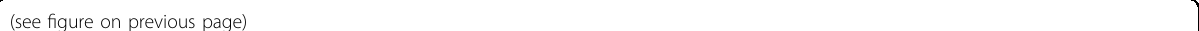
Fig. 5 CoV-2-EVs mediate the entry of SARS-CoV-2 into cells independent of known receptors and cofactors on host cells. a Expression levels of hACE-2, NRP-1, AXL and TMPRSS2 in different cell lines. b Supernatant viral copies of Vero E6, A549 and SCC7 cells after infection with SARS- CoV-2 for 24 and 48 h, respectively. Results are from more than 3 independent experiments. c Vero E6, A549 and SCC7 cells were incubated with isolated CoV-2-EVs, and supernatant viral copies were quanti fi ed by qRT-PCR. Results are from more than 6 independent experiments. d Images of Vero E6, A549 and SCC7 cells that were exposed to 2-E-mCherry-induced vesicles. Scale bars, 10 μ m. Data are the means ± SEM of three independent experiments. * P < 0.05, ** P < 0.01, *** P < 0.001. Analyses were performed using one-way ANOVA ( b ) or unpaired Student ’ s t -test ( c